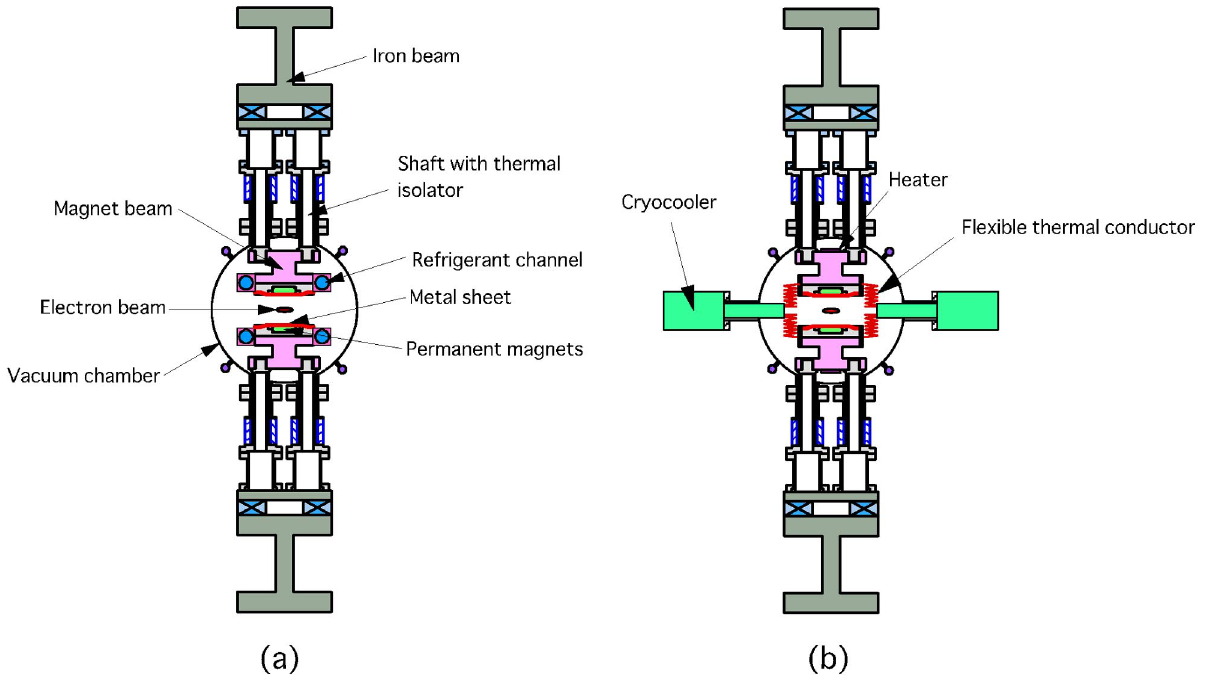
FIG. 1. (Color) Design examples of a CPMU with refrigerant channels (a) or with cryocoolers